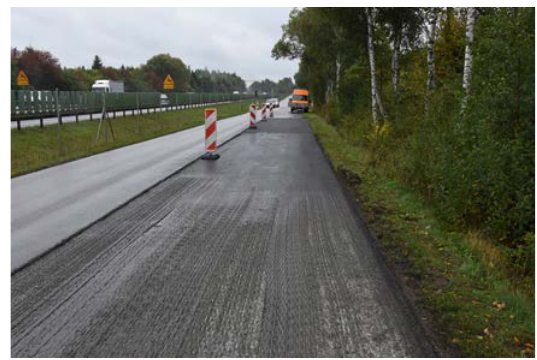
Figure 17. New binder course after surface milling.